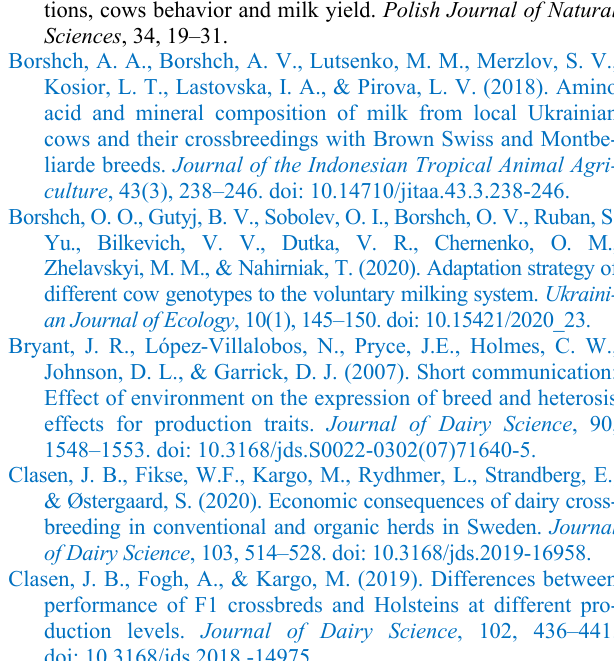
Duration of feed and dry matter consumption in first-calf heifers of the studied breeds (M ± m) Indicator Black-Pied